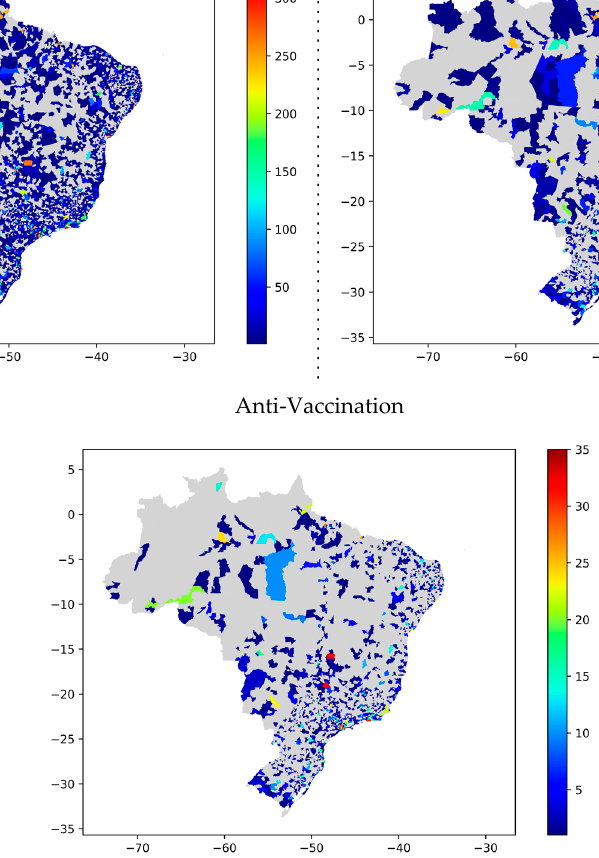
0.0020 * Defined in the form of percentages according to the population of each city. The data in Table 2 highlights that São Paulo and Rio de Janeiro (both capitals of homonymous states and the two biggest cities in terms of population) had the highest